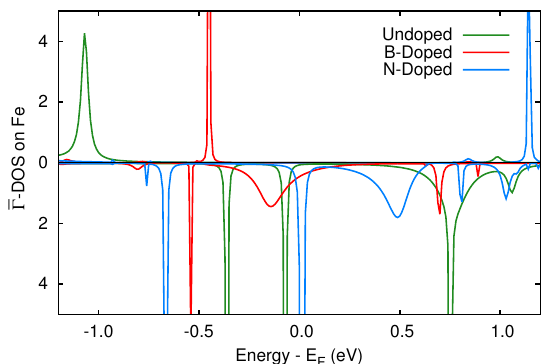
Figure 7. Γ -density of states projected on the Fe atom for the undoped (green) and doped (B in red and N in blue)